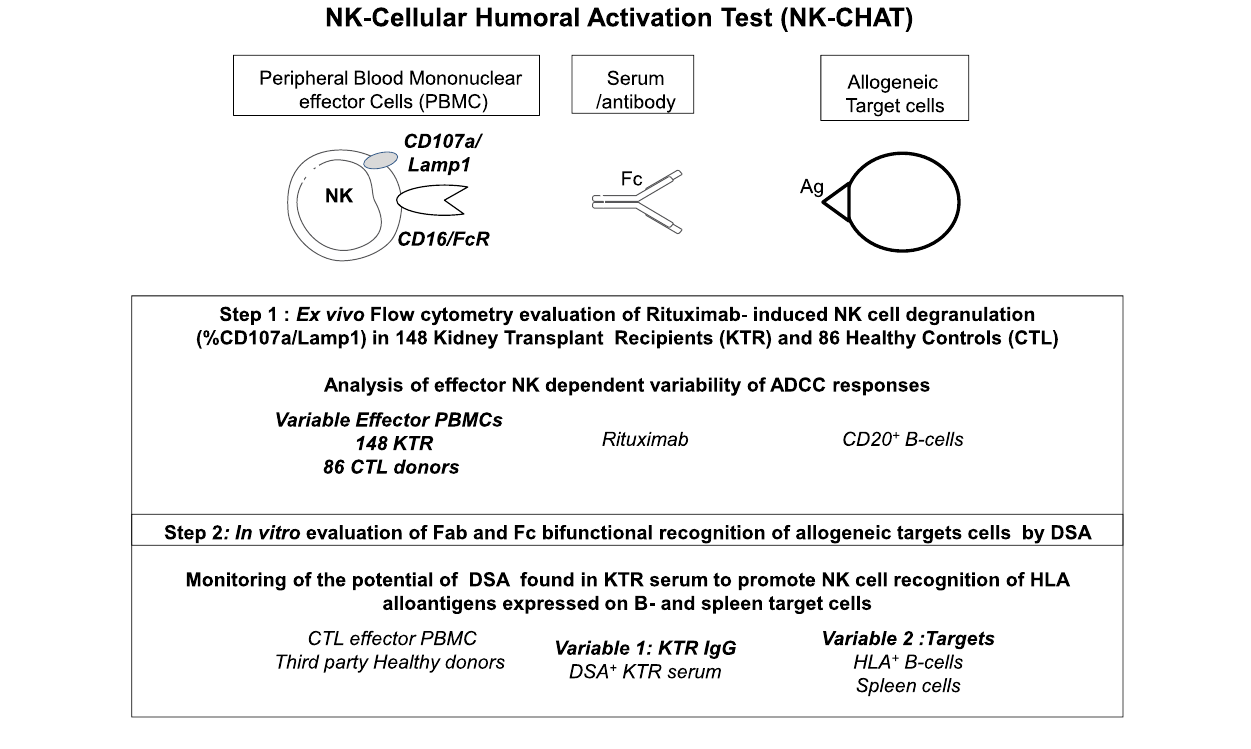
FigUre 1 | Description of the observational and in vitro steps of the study of antibody-dependent nK cell activation using a standardized nK- cellular humoral activation Test (nK-chaT) . Step 1. The standardized ex vivo NK-CHAT evaluation of the variability of KTR NK cell activation toward B cell targets coated with anti-CD20 monoclonal antibodies (rituximab). Step 2. In vitro scoring of serum DSA activity toward allogeneic target cells using third-party PBMCs isolated from healthy blood donors as immune effector